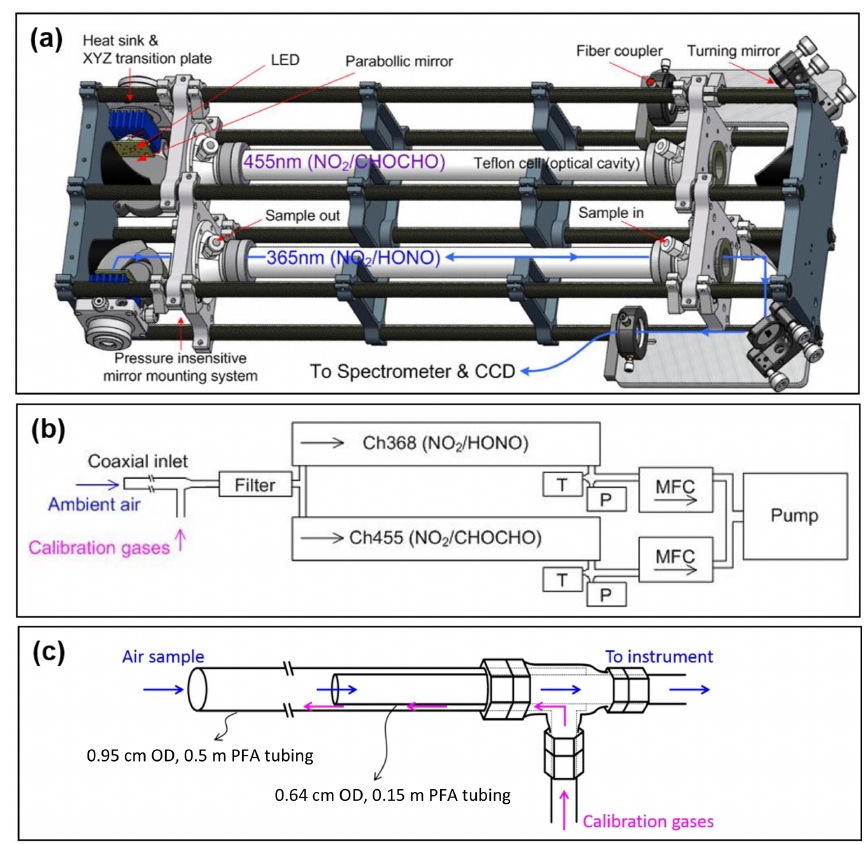
Figure 1. (a) ACES optical system, showing the LEDs, collimating optics, and high-finesse cavities defined by the high-reflectivity mirrors. The system is mounted on six carbon rods to achieve an optical alignment that is insensitive to vibration and pressure changes. (b) ACES flow system, showing the inlet, aerosol filter, two cells, temperature ( T ) and pressure ( P ) sensors, mass flow controllers (MFC), and pump. (c) ACES inlet system, consisting of an outer Teflon FEP tube (0.95cm OD, 0.79cm ID, 0.5m long) and coaxial inner Teflon FEP tube (0.64cm OD, 0.15m long). The coaxial design allows calibration gases to be added without affecting the inlet